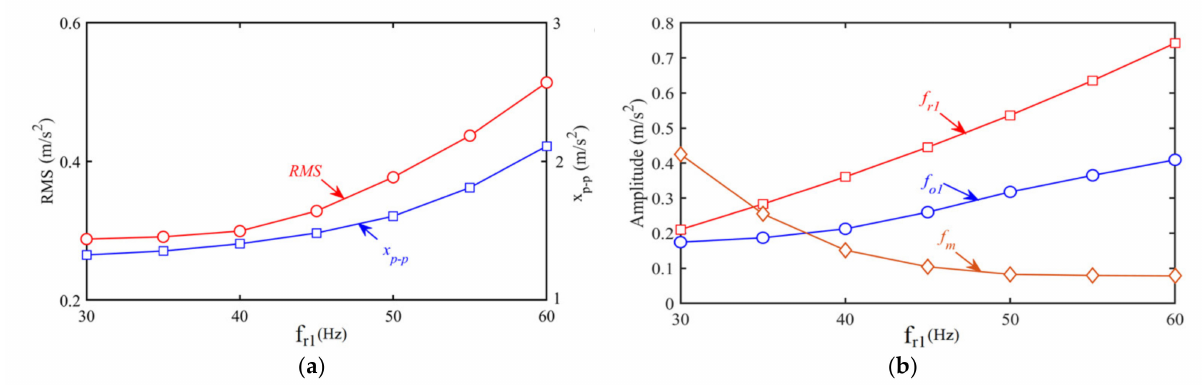
Figure 11. Indicators for vibration characteristics of the bearing-rotor-gear system at different speeds: ( a ) RMS and x p-p ; ( b ) amplitudes of f r 1 , f o 1, and f m .